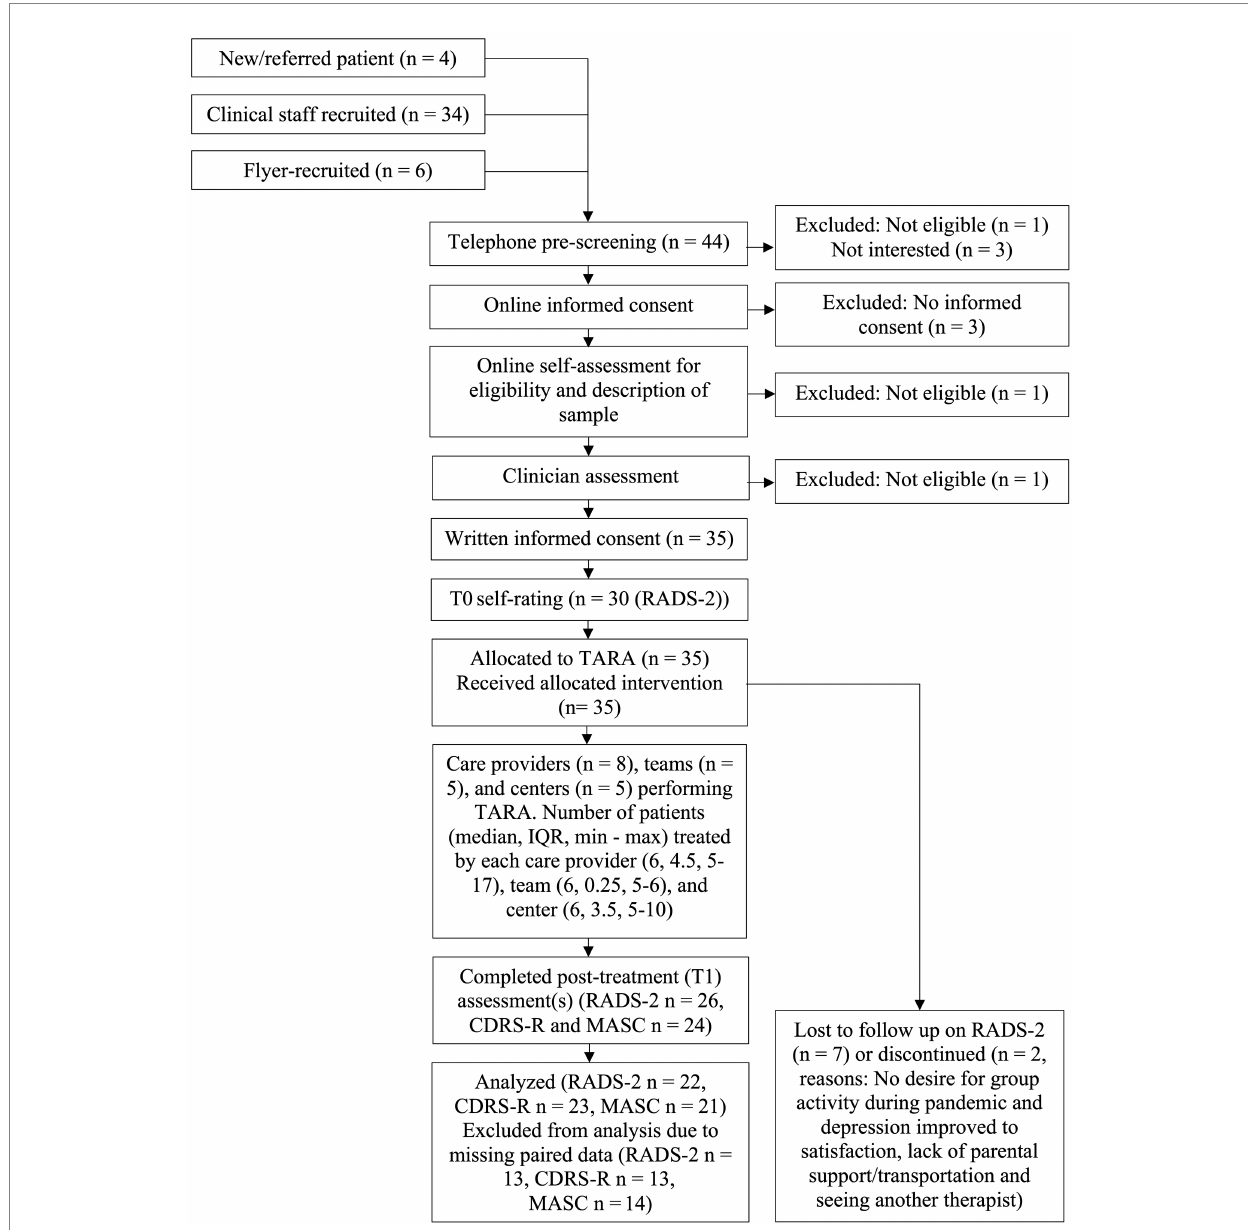
FIGURE 1 Flow of participants. CDRS-R, Children’s Depression Rating Scale—Revised; IQR, interquartile range; MASC, Multidimensional Anxiety Scale for Children; n , number of participants; RADS-2, Reynolds Adolescent Depression Scale 2nd edition; TARA, Training for Awareness, Resilience and